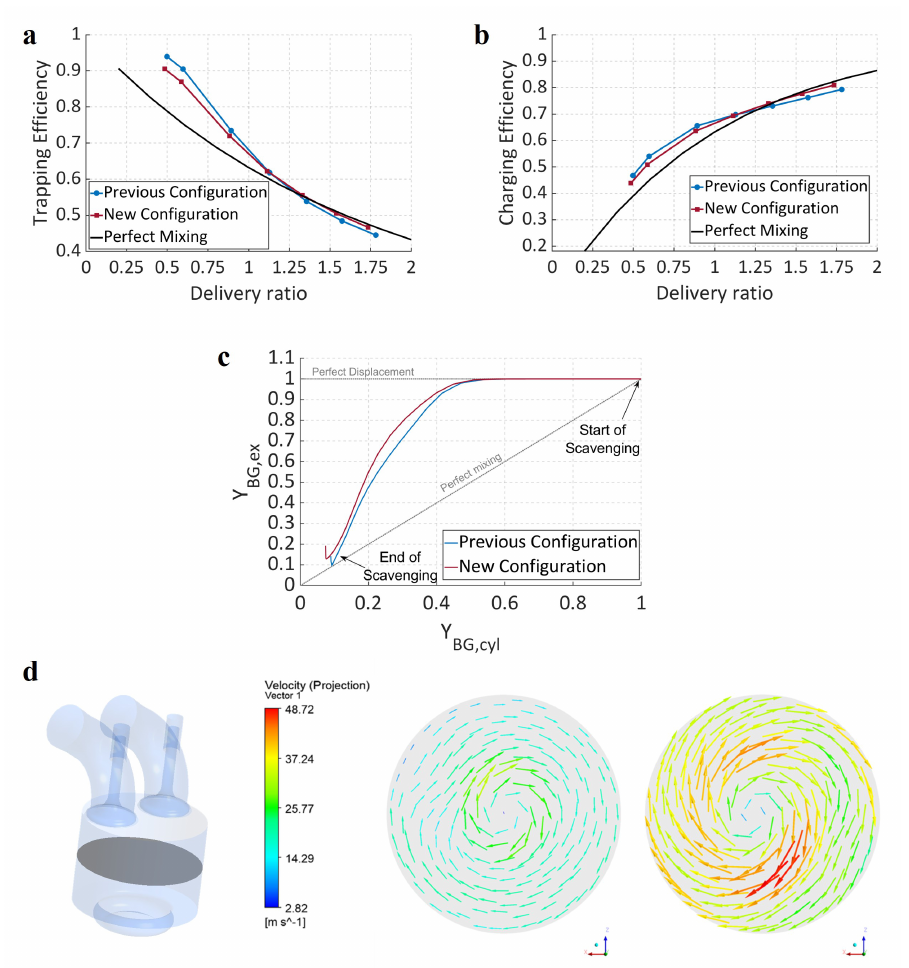
Figure 19. New geometry scavenging performance. ( a ) Trapping efficiency for the old and the new geometry. ( b ) Charging efficiency for the old and the new geometry. ( c ) Burned gas mass fraction in the exhaust ducts versus burned gas mass fraction in the cylinder with G = G b for the old and the new geometry. ( d ) Velocity vectors colored with velocity magnitude in the middle-height section with G = G b for the old (left) and the new (right)